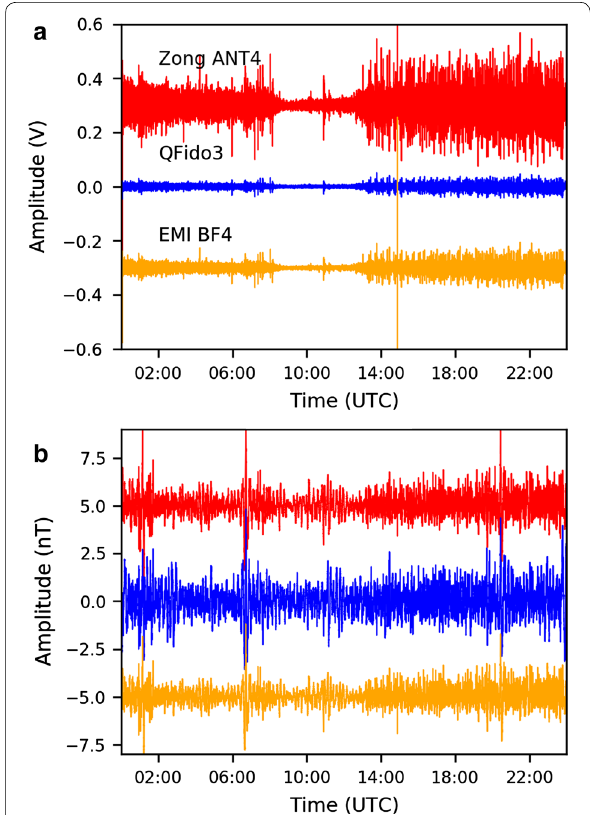
Fig. 8 Day-long time series for April 12, 2014, recorded in a voltage and b nanotesla (i.e., after correction for instrument response). All data are from the north–south coils and are shown after a 1000-s high-pass filter. The time series are all zero-mean but are plotted with an offset for easier visual comparison